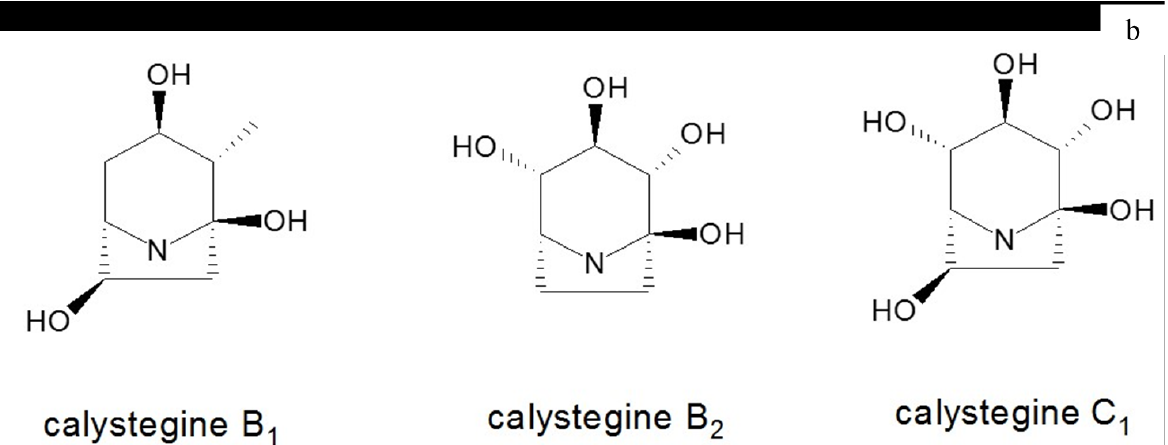
Figure 1b. Structures of the glycosidase-inhibitory alkaloids of the tropane found in the plant Ipomoea carnea